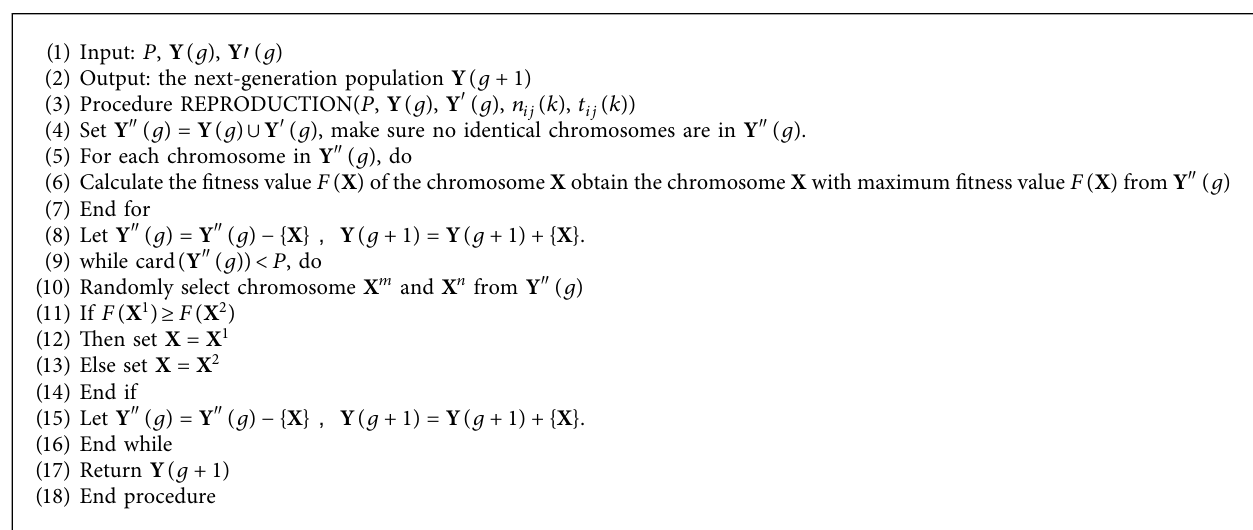
A LGORITHM 4 : Reproduction algorithm in Genetic algorithm.